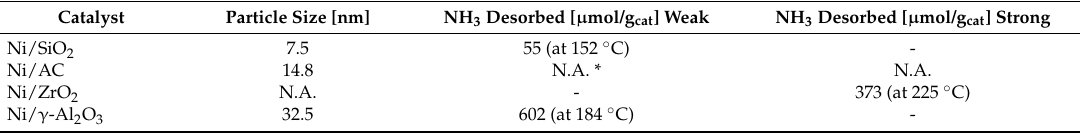
Table 2. The particle size and acidities of the 5.0 wt.% nickel based catalysts.